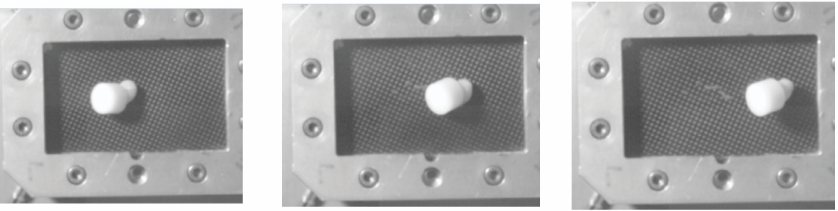
Figure 23. Sample 3, CF, smooth gravel, 2.7 J, 28.5 degrees, showing the initial ( left ), intermediate ( centre ), and gravel detachment stages ( right